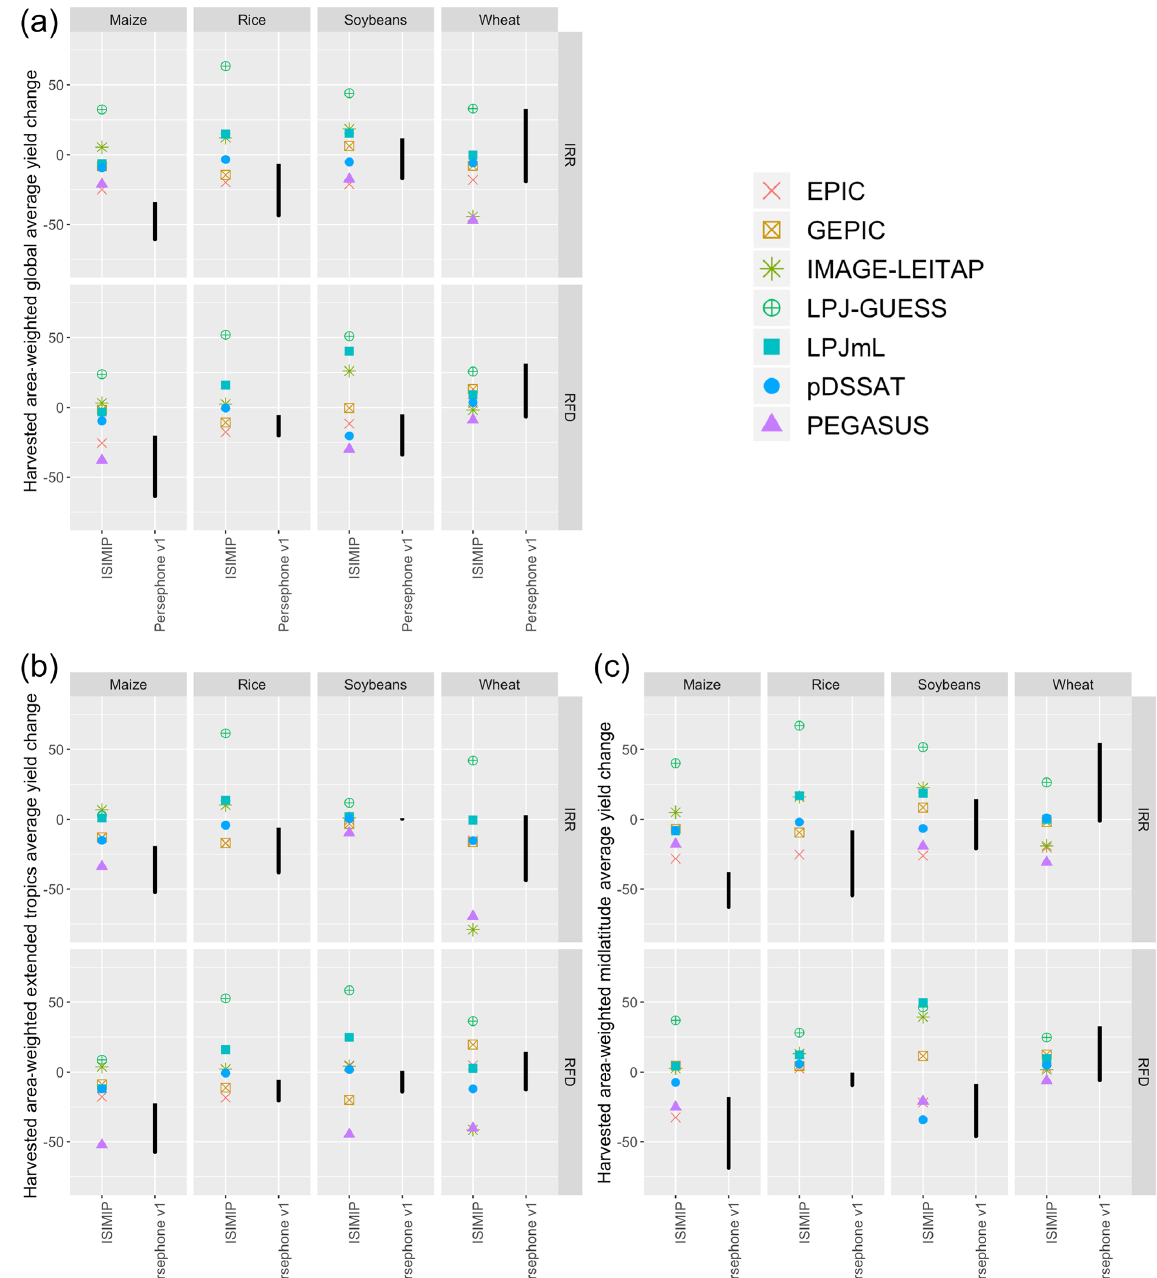
Figure 12. Aggregated (via MIRCA2000 harvested area; Portmann et al., 2010), time-averaged 2071–2100 yield changes for Persephone v1.0 response functions and the ISIMIP GGCM range of results for multiple production groups. (a) Comparison of global average yield changes. (b) Comparison of average yield changes in the extended latitude band. (c) Comparison of average yield changes in the midlatitude